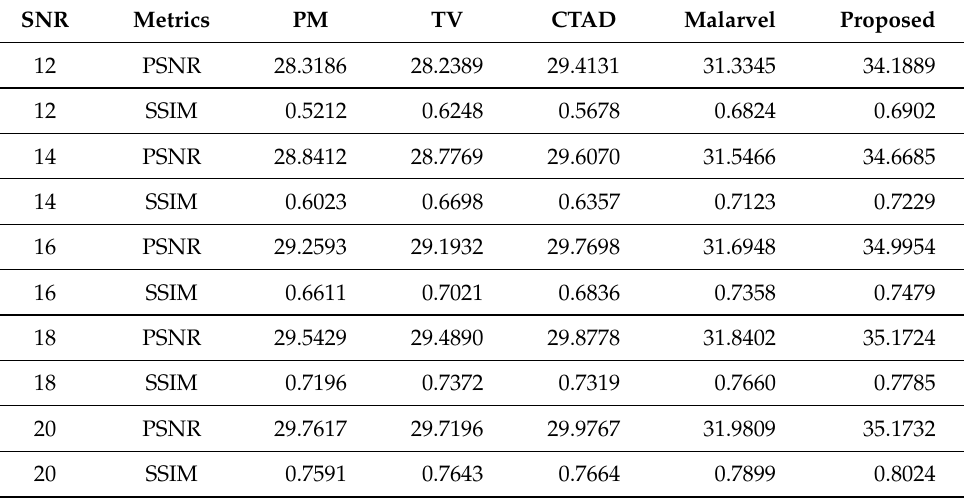
Table 3. Fruits image experiment results